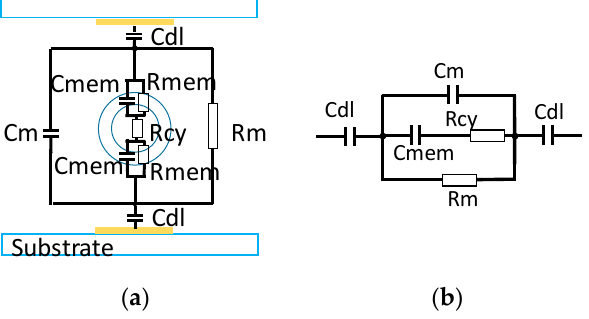
Figure 1. ( a ) Electrical components diagram for a cell in suspension between two identical parallel electrodes and ( b ) its electrical model.